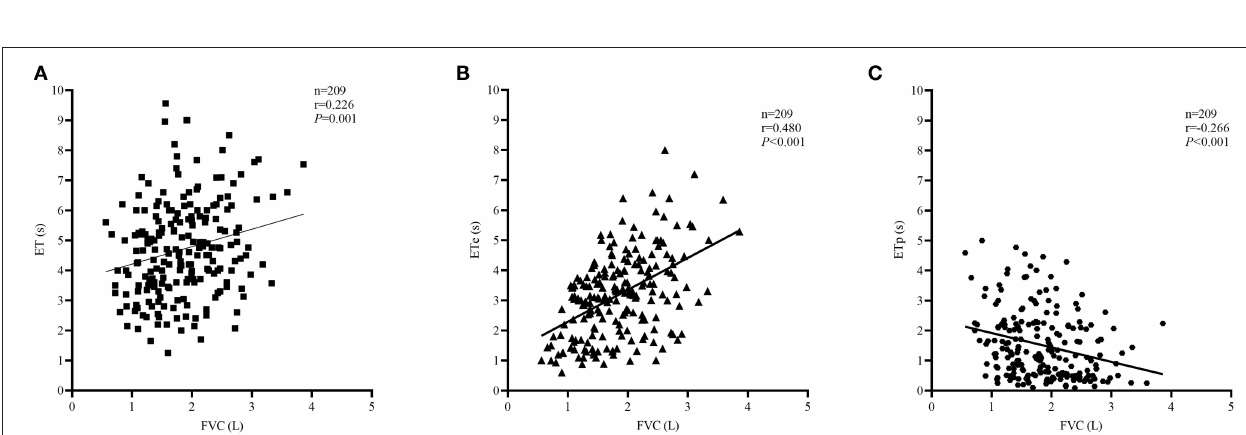
Frontiers in Pediatrics |